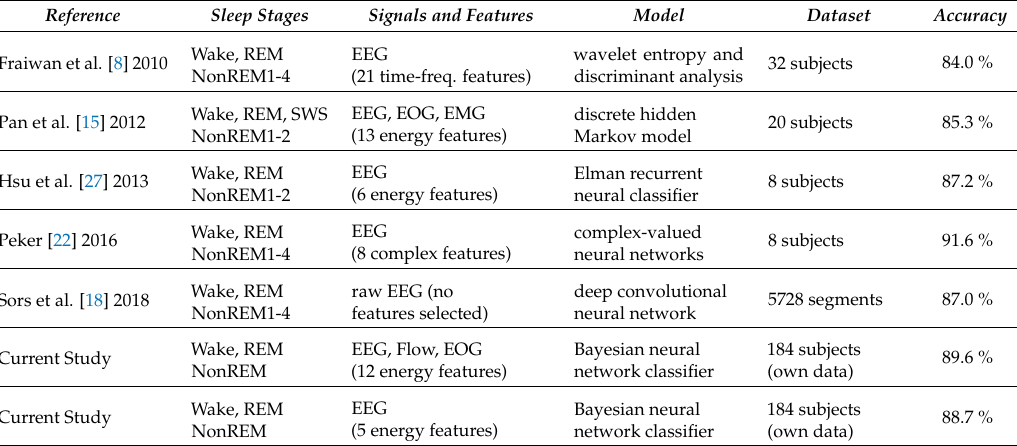
Table 9. A comparison of the proposed method with further published